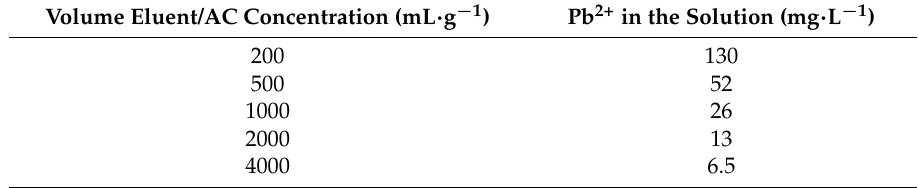
Table 11. Pb 2+ concentration in the eluent solution at various eluent volume/AC concentration